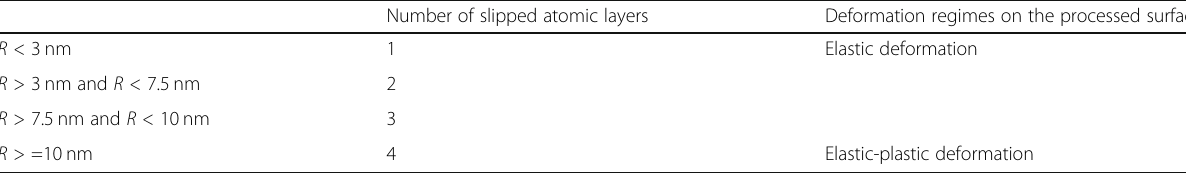
Table 2 Atom displacement behaviour versus cutting edge radius